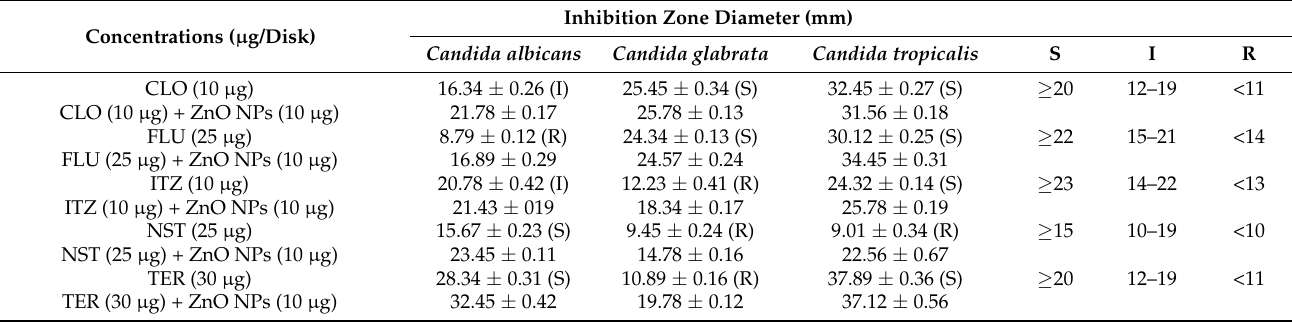
Figure 11. Synergistic percentages of green synthesized zinc oxide nanoparticles with different antifungal agents. Table 3. Antifungal efficiency of the biogenic ZnO NPs compared to different antifungal